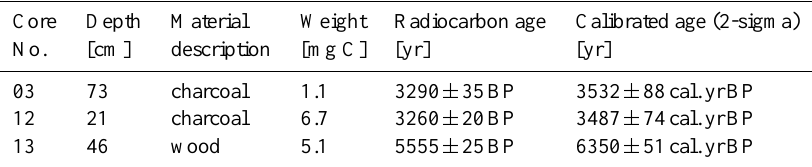
Table 3. Radiocarbon data and IntCal09 calibrated ages (Bronk Ramsey, 2009; Reimer et al., 2009) for three samples in the vicinity of Kaliˇsta spring